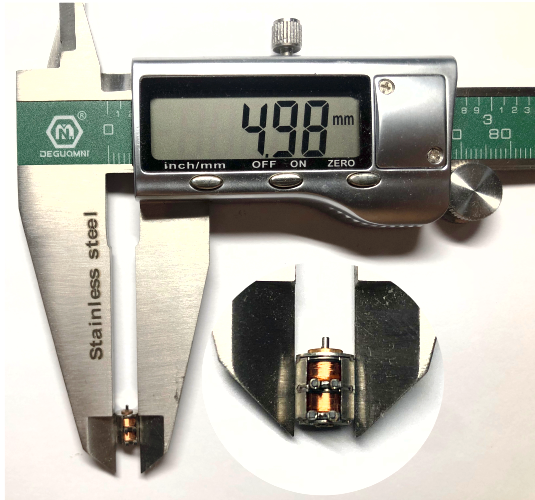
Figure 11. Photo of a 5 mm stepper motor.